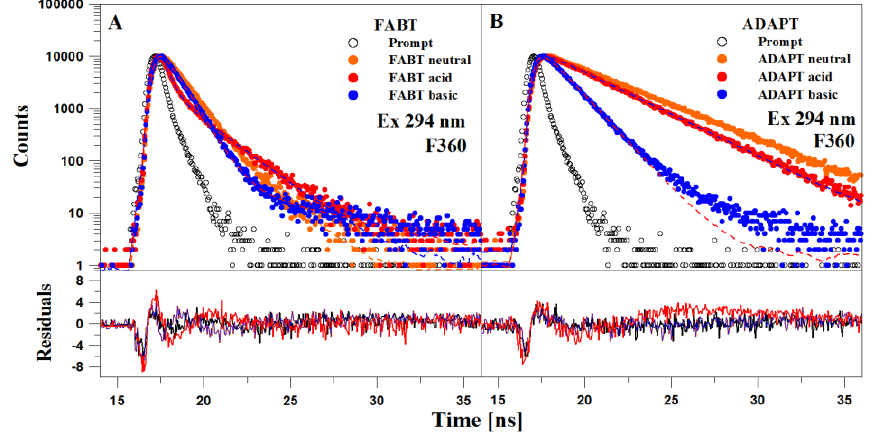
Figure 6. Panel ( A ). TCSPC analysis for FABT in EtOH and EtOH with the addition of acid and base (apparent pH). The top panel presents the decay of fluorescence intensity. Black color denotes the apparatus profile. Points correspond to measurement results and the continuous line to the double component analysis. The bottom panel presents the distribution of residuals. The excitation wavelength was 294 nm. Panel ( B ). TCSPC analysis for ADAPT in EtOH and EtOH with the addition of acid and base (apparent pH). The top panel presents the decay of fluorescence intensity. Black color denotes the apparatus profile. Points correspond to measurement results and the continuous line to the double component analysis. The bottom panel presents the distribution of residuals. The excitation wavelength was 294 nm, fluorescence emission was recorded for wavelength > 360 nm (emission filter F360).